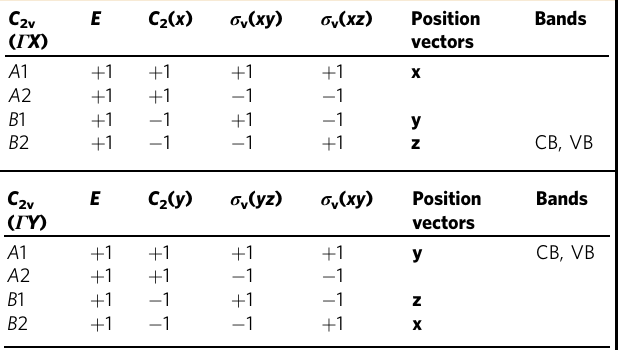
The main C 2 rotation symmetry operations for both point groups are along the x and y axes, respectively, giving different irreducible representations for the position vectors. The irreducible representations for the conduction and valence bands, determined by analysis of orbital symmetries are also presented (adapted from ref. 30 )